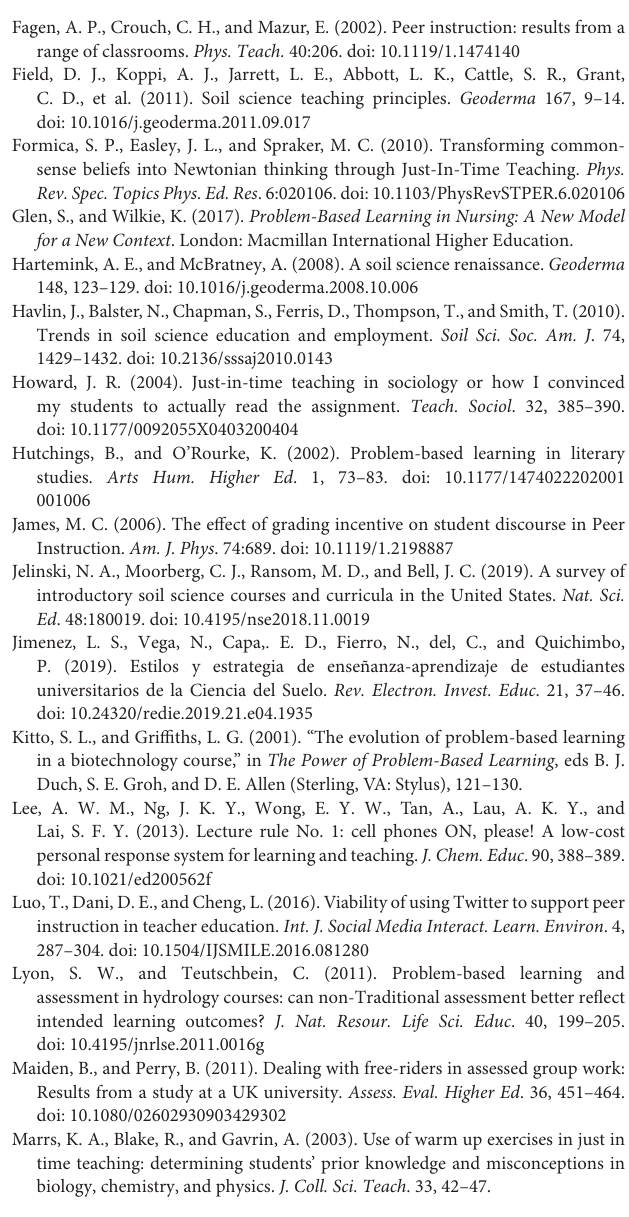
Supplementary Figure 1 | Sample questions used for peer instruction during